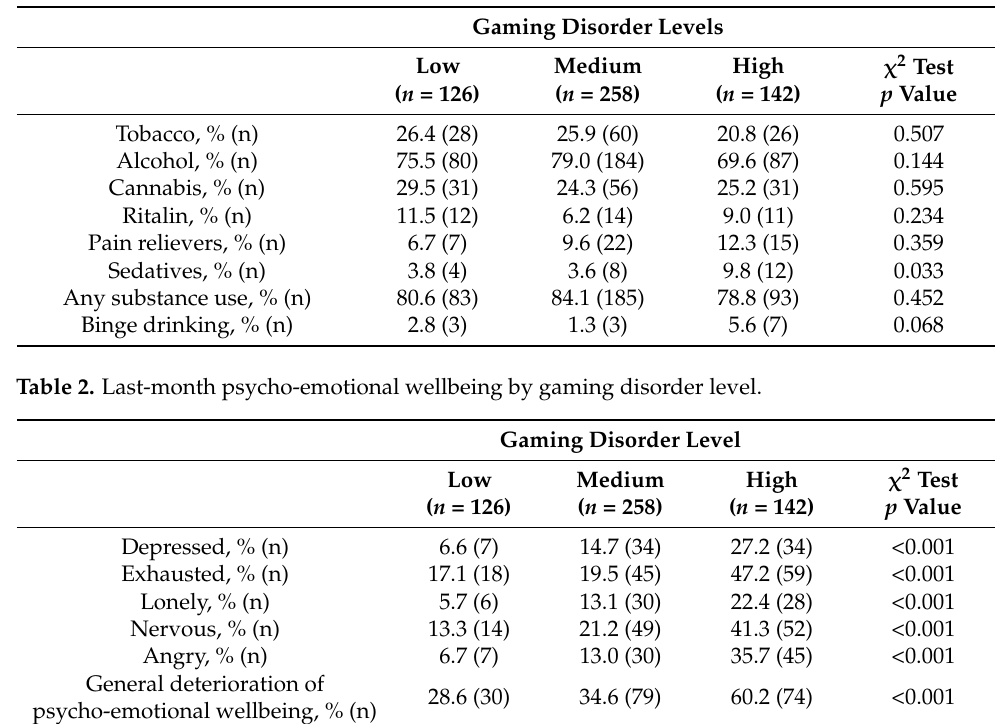
Table 1. Last-month substance use by gaming disorder level.